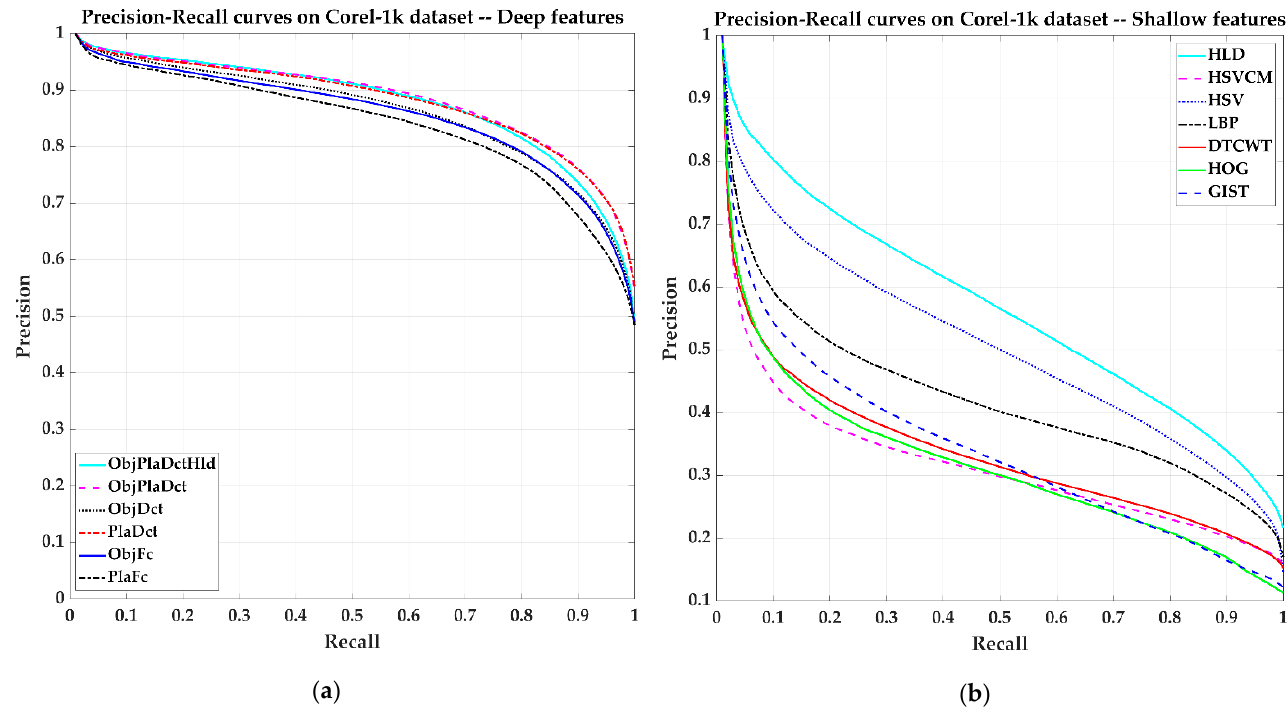
Figure 8. Precision vs. recall curves by some methods on the Corel-1k dataset. ( a ) The methods based on deep features. ( b ) The methods based on shallow features.